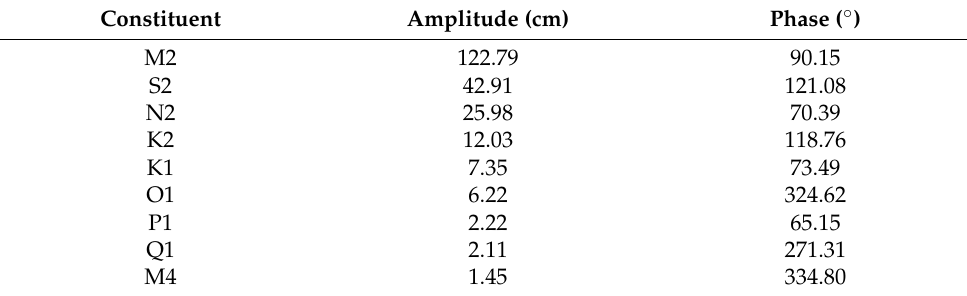
Table 1. Main tidal constituents in the Ria de Ortigueira.